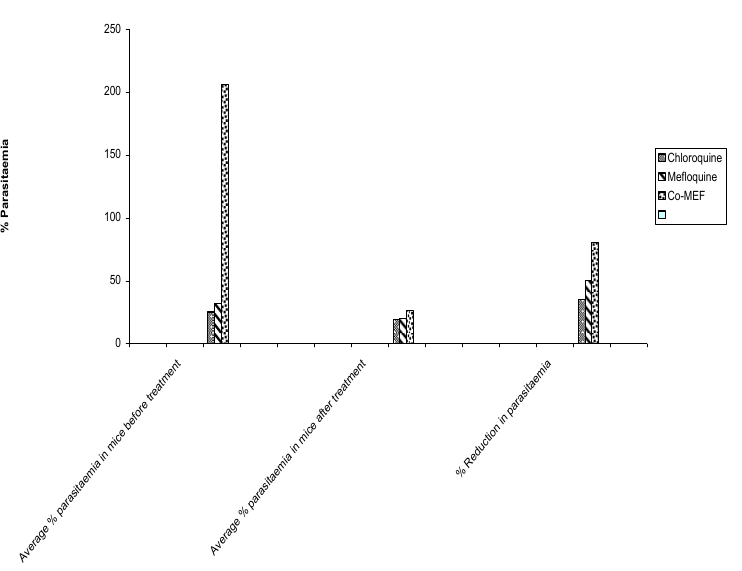
Figure 6. Percentage Parasitaemia Of Ligand and Metal Complex Using Mice infected with Plasmodium yoelii